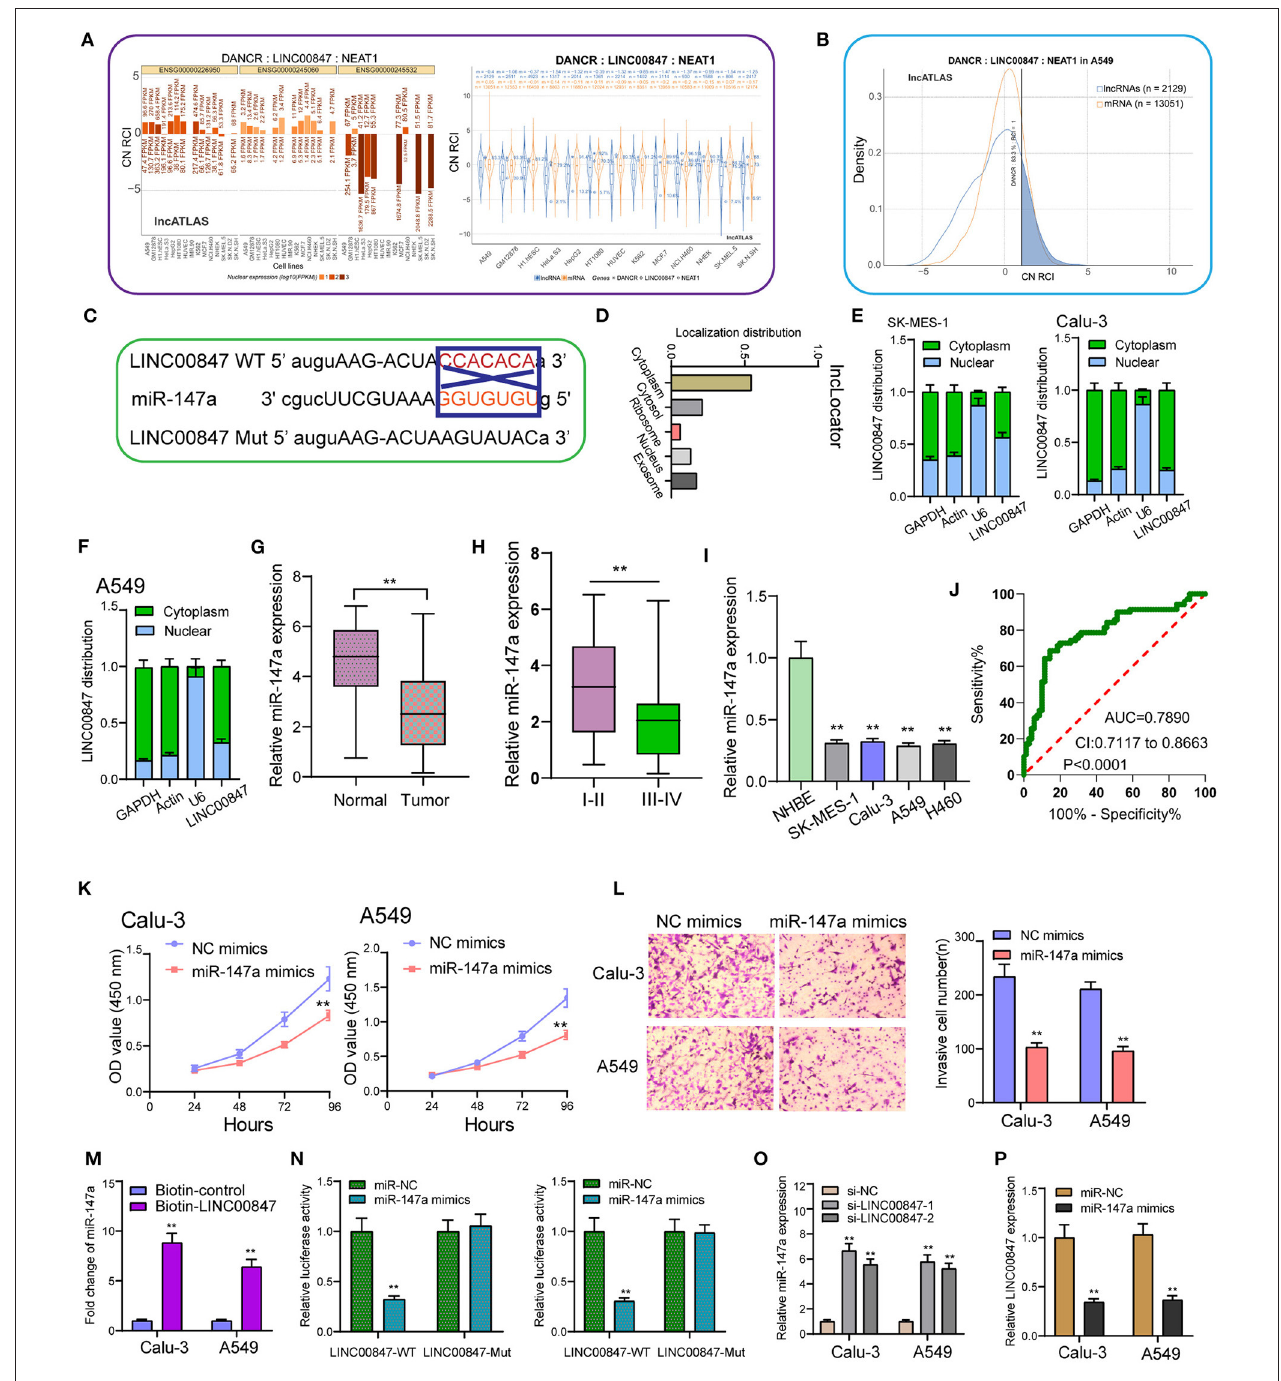
FIGURE 5 | miR-147a is predicted to interact with LINC00847. (A) The subcellular localization of LINC00847 in several types of tumor cells based on the data of LncATLAS. (B) Cytoplasmic/Nuclear Localization: RCI distribution in A549 cells. (C) The schematic diagram presents the complementary binding sites within LINC00847 and miR-147a. (D) Localization distribution of LINC00847 by analyzing lncLoctor. (E, F) Relative LINC00847 expression levels in nuclear and cytosolic fractions of SK-MES-1, Calu-3 and A549 cells. (G) RT-PCR for the determination of miR-147a expression in our cohort. (H) The levels of miR-147a in NSCLC with different stages. (I) The down-regulation of miR-147a was observed in NSCLC cells. (J) The diagnostic value of miR-147a was determined using ROC assays. (K) CCK-8 assays determined the proliferation ability of Calu-3 and A549 cells after transfection of miR-147a mimics. (L) Trans well-assay was used to detect cell invasion in miR-147a mimics transfected Calu-3 and A549 cells. (M) RNA-pull down experiments suggested the combination between miR-147a and LINC00847. (N) Luciferase reporter assay showed the activity within miR-147a and LINC00847 wild type or mutant. (O) The levels of miR-147a was increased in Calu-3 and A549 cells after the transfection of si-LINC00847-1 and si-LINC00847-2. (P) Overexpression of miR-147a inhibited the expression of LINC00847. ** p < 0.01.